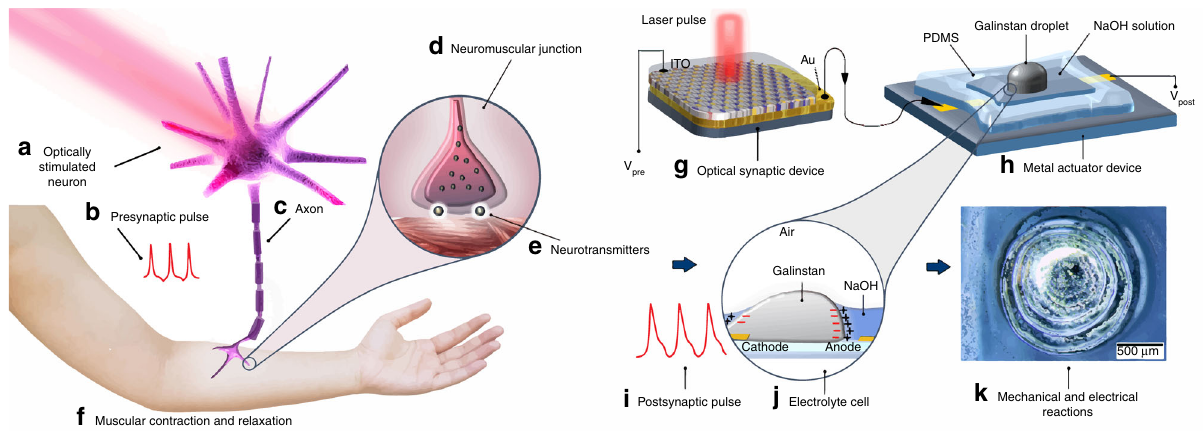
Fig. 1 The scheme of opto-genetically engineered neuron system and arti fi cial optoelectronic sensorimotor device. a – f In a biological system a the optically stimulated neurons, which contain photosensitive proteins generate b presynaptic pulses through c axons to d neuromuscular junctions. e Neurotransmitters convey the presynaptic pulses to muscle fi bre to cause the f postsynaptic reactions like muscular contraction and relaxation. Analogously, g – k in the arti fi cial sensorimotor system g an optical synaptic device is integrated into a h metal actuator device. The optical synaptic device is triggered by pulsed lights to generate i postsynaptic pulses. The transferred postsynaptic potential pulses to the liquid metal actuator device oscillate the galinstan droplet in NaOH solution, which is in fact an j electrolyte cell. The outputs of device can be recorded either as k mechanical or electrical